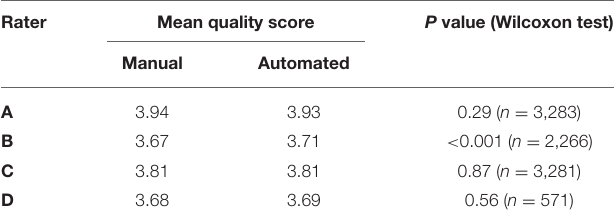
TABLE 1 | Comparison of the mean quality score for manual and automated contours, and their corresponding Wilcoxon test p-value for statistical significance, for each